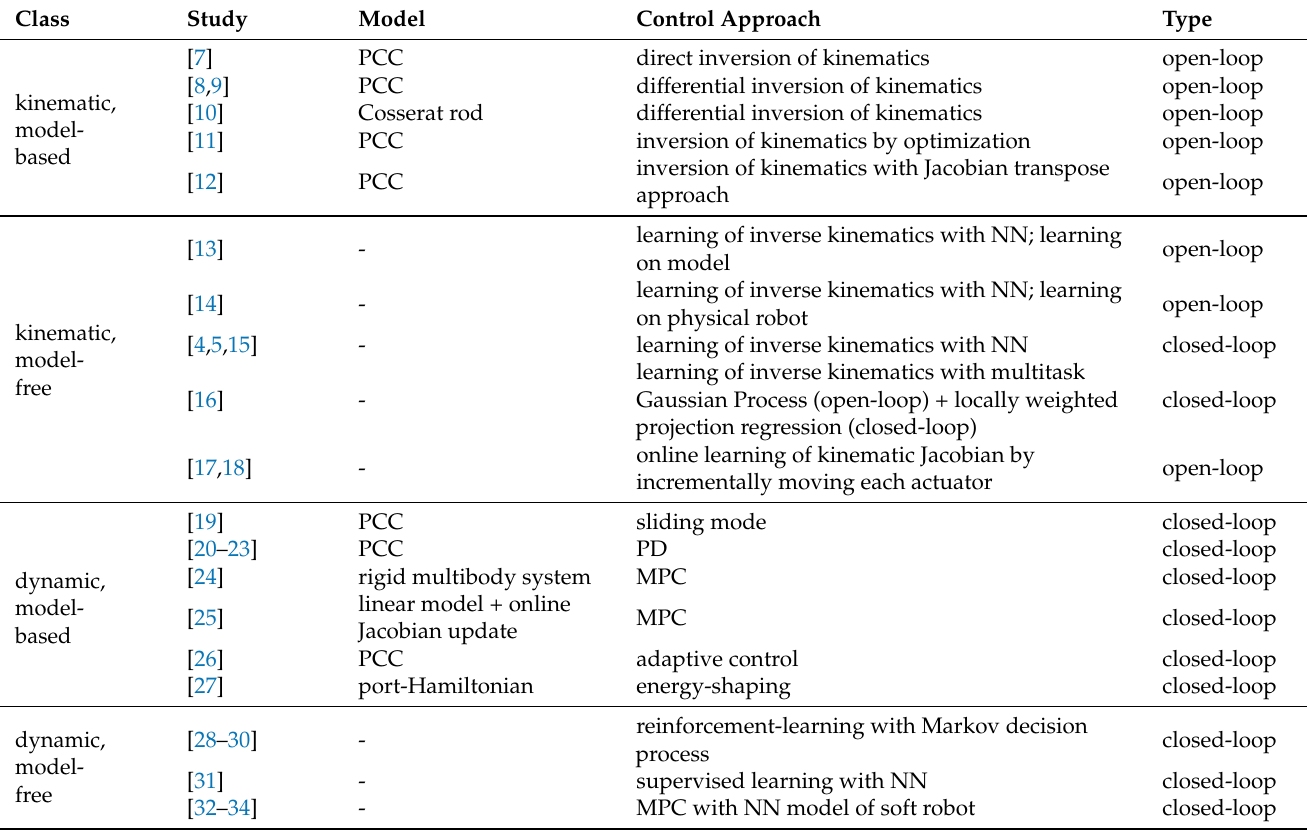
Table 1. Comparison of state-of-the-art control approaches for soft